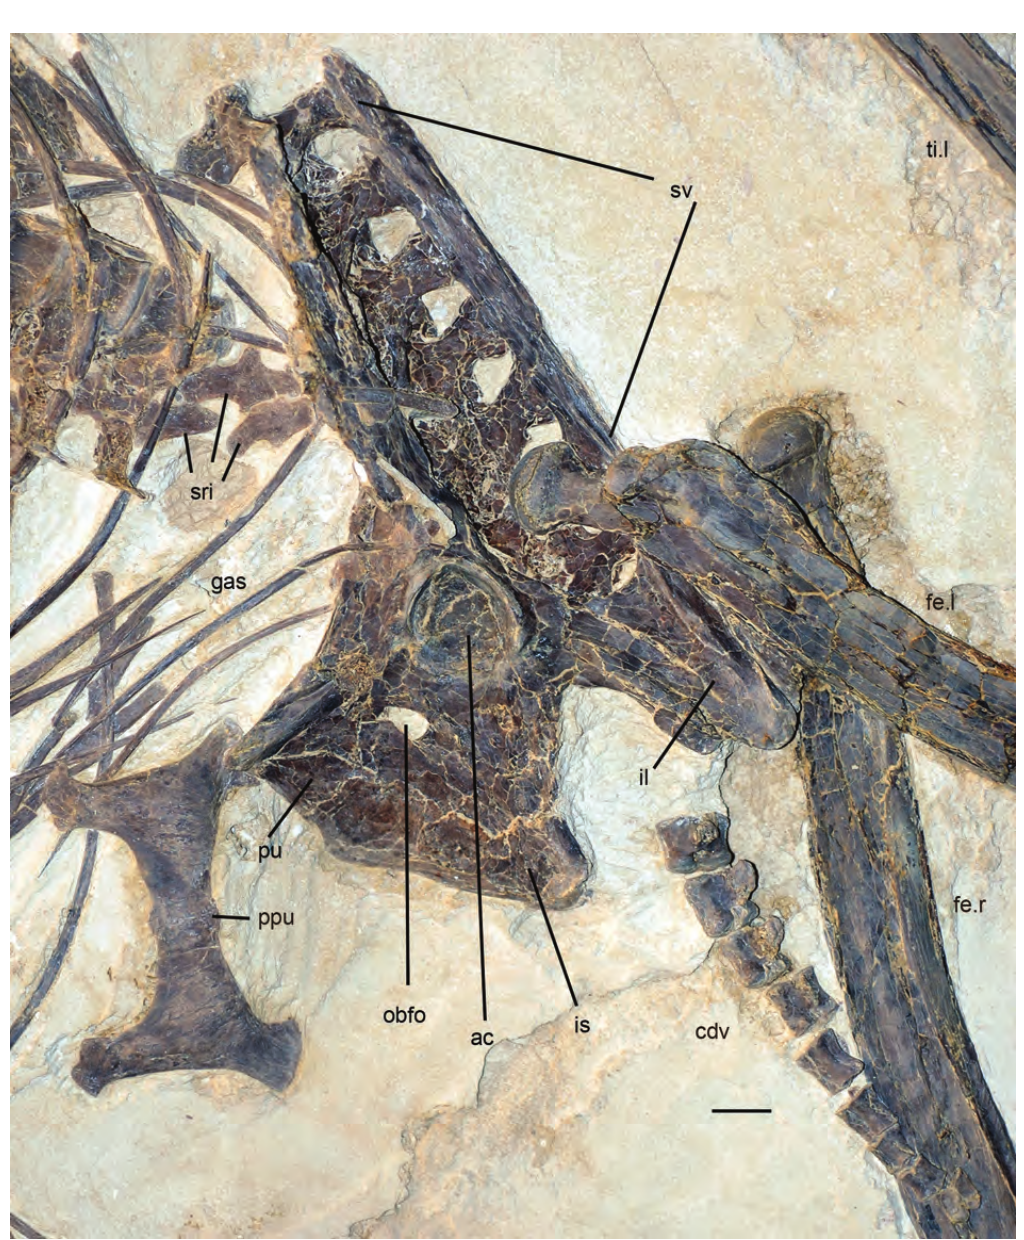
Fig. 4 – Dawndraco kanzai gen. et sp. nov., holotype (KUVP 27821) part of the skeleton showing the pelvis and the caudal vertebrae. Scale bar: 10